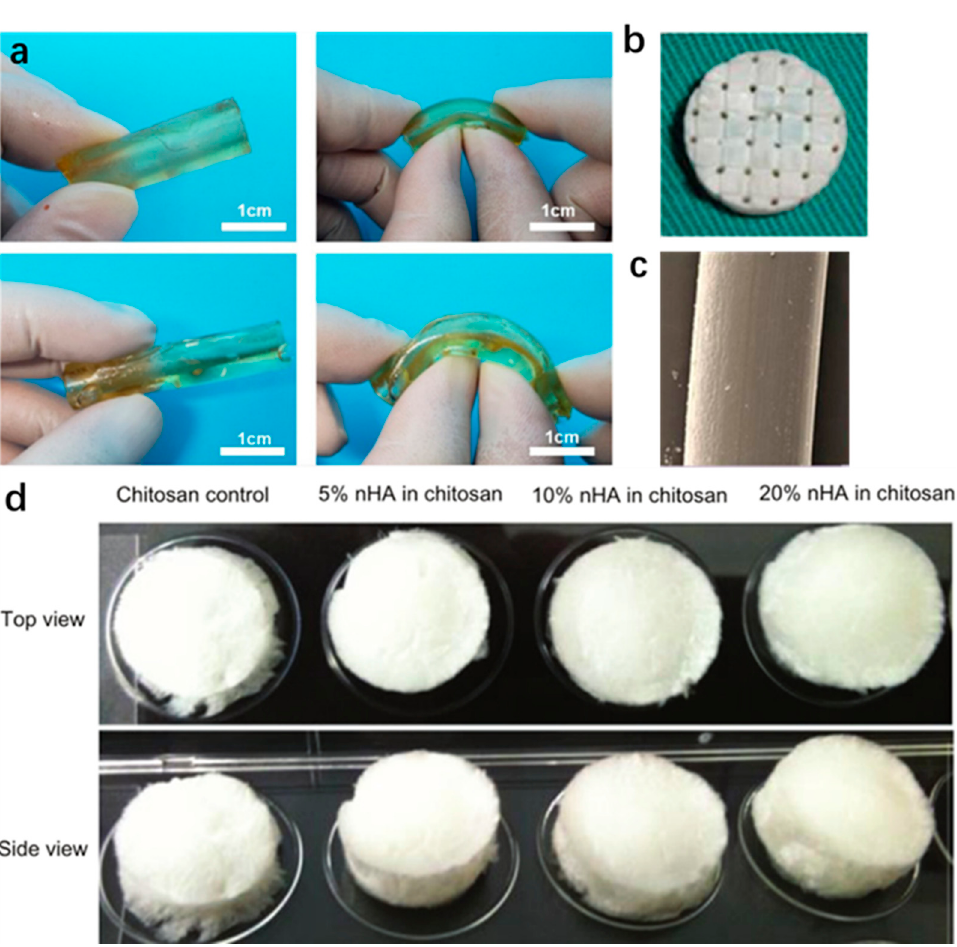
Figure 5. Applications of common polymers in biological tissue engineering: ( a ) morphology of 20peg-1.0C/H and 40peg-1.5C/H pipes [96]; ( b ) silk fibroin scaffold [97]; ( c ) PLA bone implant [98] (the figure can be viewed at wileyonlinelibrary.com); ( d ) chitosan/nHA scaffold prepared after freeze drying [99] (From International Journal of NanoMedicine 2012 7 2087-2099’ Originally published by and used with permission from Dove Medical Press Table 3. Characteristics of common polymers and their applications in bone tissue engineering.